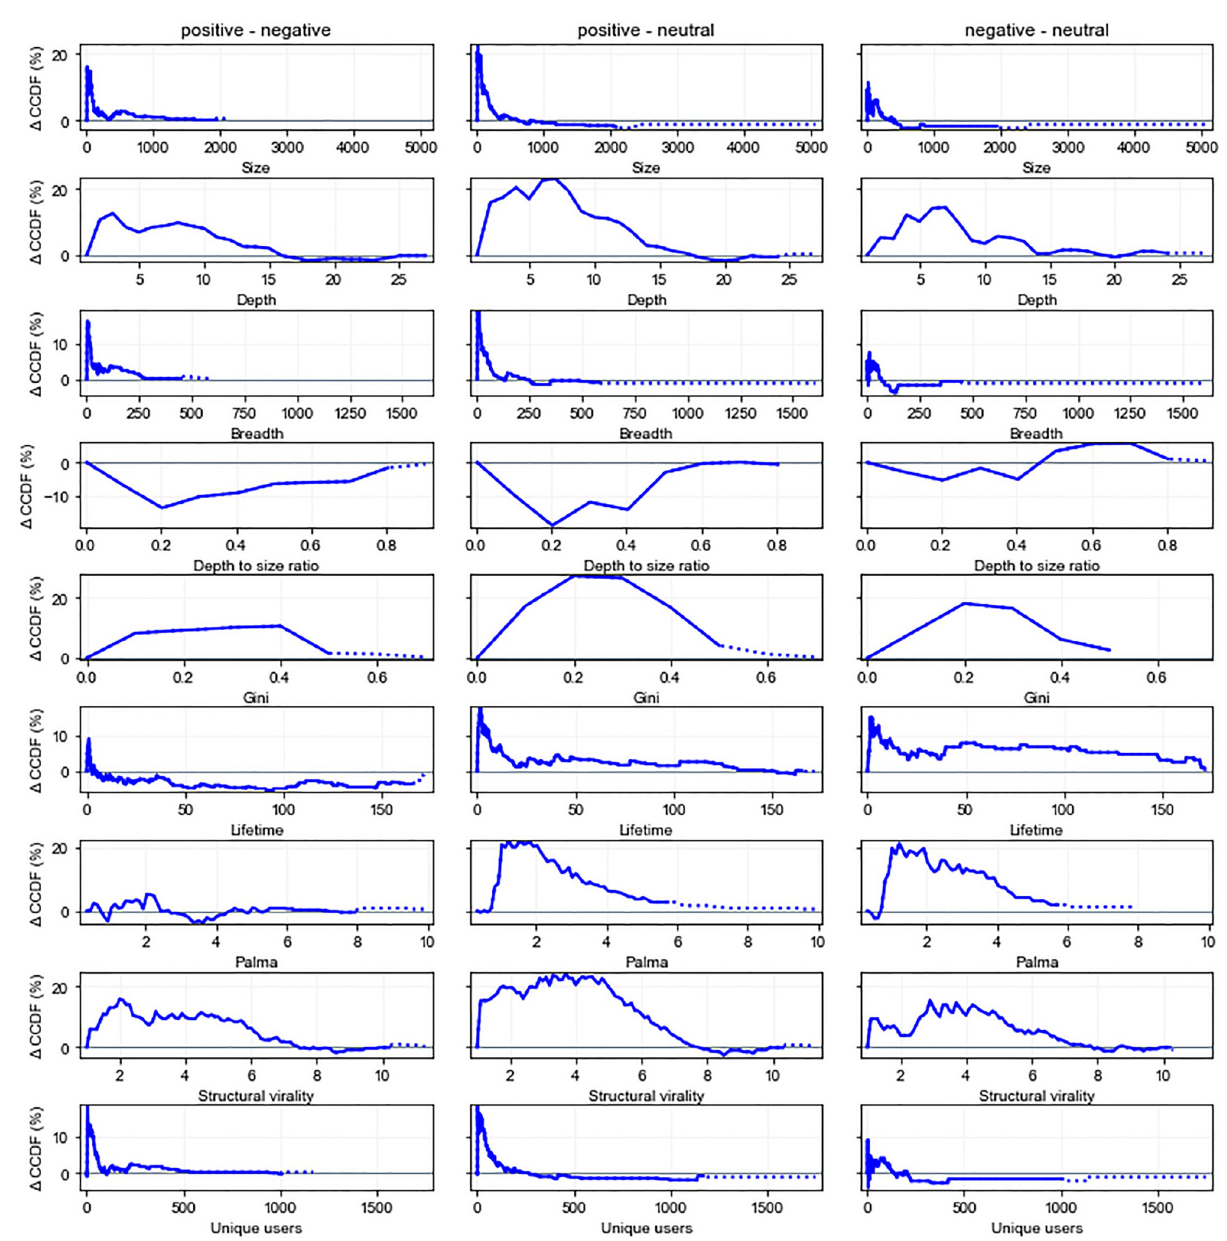
Fig 13. Differences in vulnerability spread for Reddit posts that are subjective (positive, negative polarity) vs. neutral. Differences are taken between CCDFs for all polarity